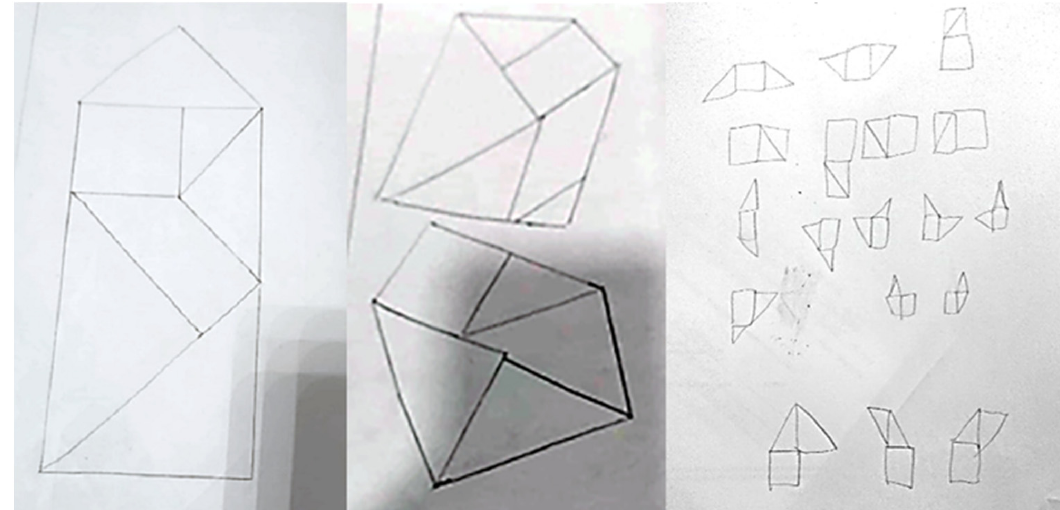
Figure 20. Attempts to fill out a pentagon shape and to find combinations for Task 2.